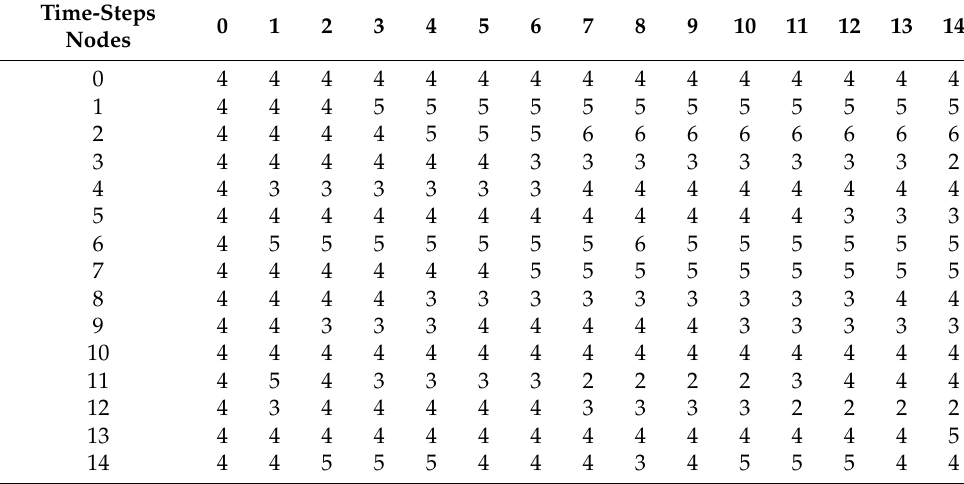
Figure 6. Small world network emergence generated. Table 5. Time series showing the node degrees generated at each time-step of a small world network.